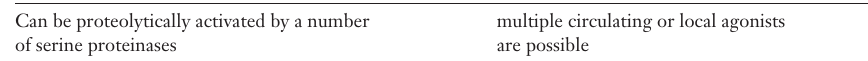
Unique features of PARs.